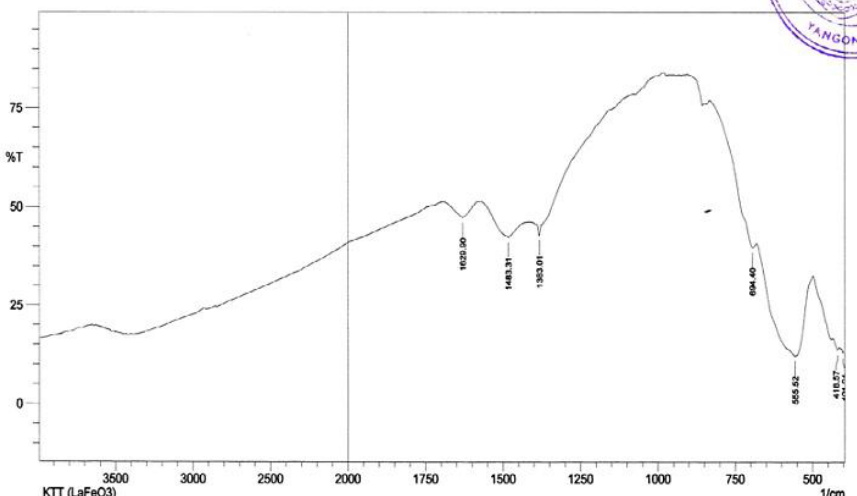
Figure 6. FT IR spectrum of LaFeO ₃ nanocrystalline particle calcined at 450 ° C